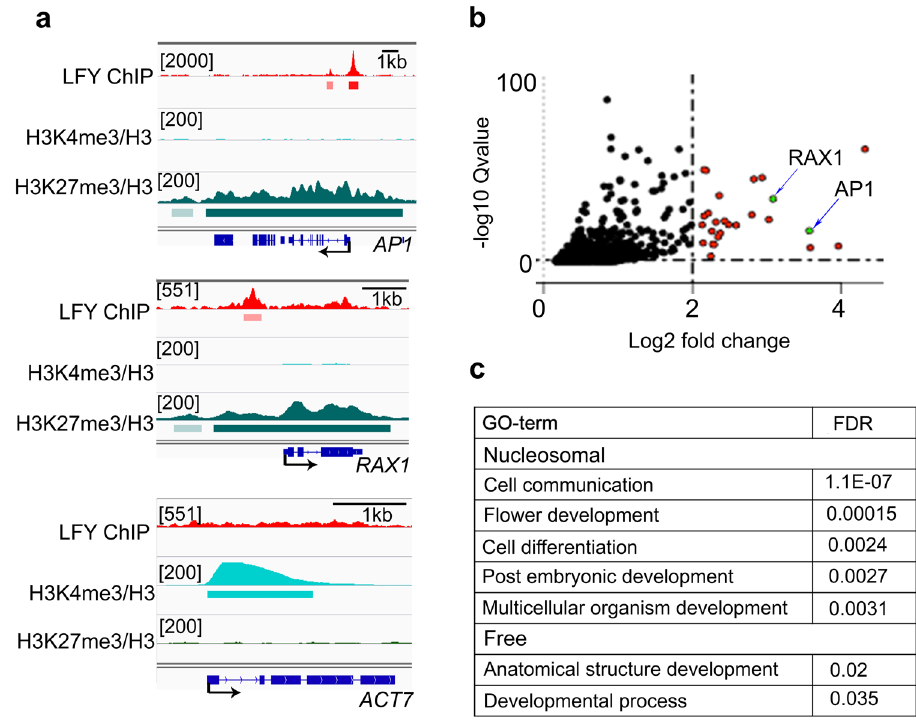
Fig. 5 LFY binding in the context of nucleosome-enriched chromatin activates fl ower related genes. a Browser view of LFY occupancy (this study) and presence of H3K27me3/H3 or H3K4me3/H3 based on analysis of a public ChIPseq dataset 69 in root explants at AP1 , RAX1 , and ACT7 . Signi fi cant ChIP peaks ( q value ≤ 10 − 10 MACS2 for LFY and q value ≤ 10 − 100 for histone modi fi cations) are marked by horizontal bars, with the color saturation proportional to the negative log 10 q value (as for the narrowPeak fi le format in ENCODE). b Volcano plot of genes differentially expressed 24 h after dexamethasone relative to mock treatment ( n = 2042, adjusted DESeq2 p value ≤ 0.01). Red color denotes log 2 FC ≥ 2, arrows point to AP1 and RAX1 . c Signi fi cantly enriched development related Gene Ontology terms for LFY regulated genes whose LFY binding site was nucleosome occupied (Nucleosomal n = 202, FDR < 0.005; top) or nucleosome free (Free n = 101, FDR < 0.05; bottom). All signi fi cant GO terms identi fi ed are listed in Supplementary Data 2. See also Supplementary Fig.